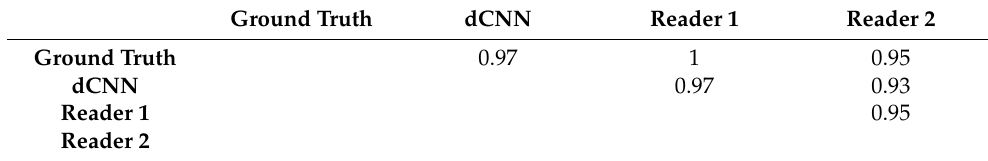
Table 3. Cohen’s Kappa coefficients of the classification results between the “ground truth”, trained dCNN, and each of the two